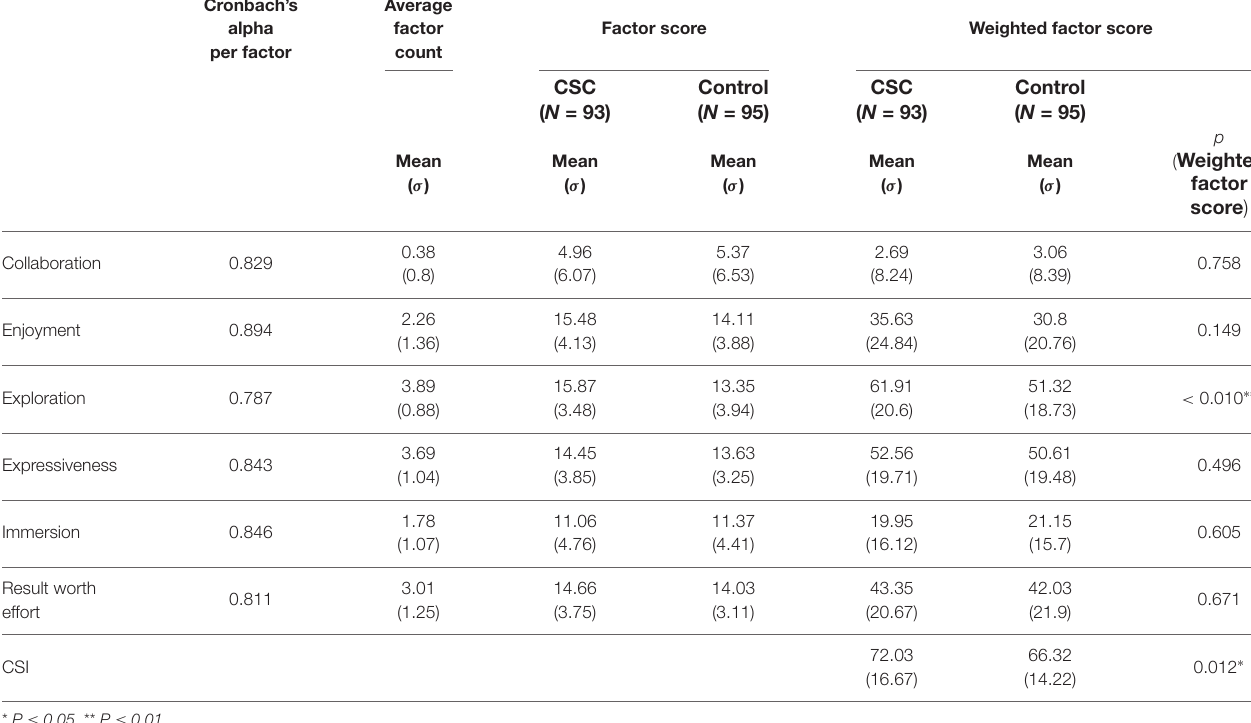
TABLE 5 | CSI and factor scores.